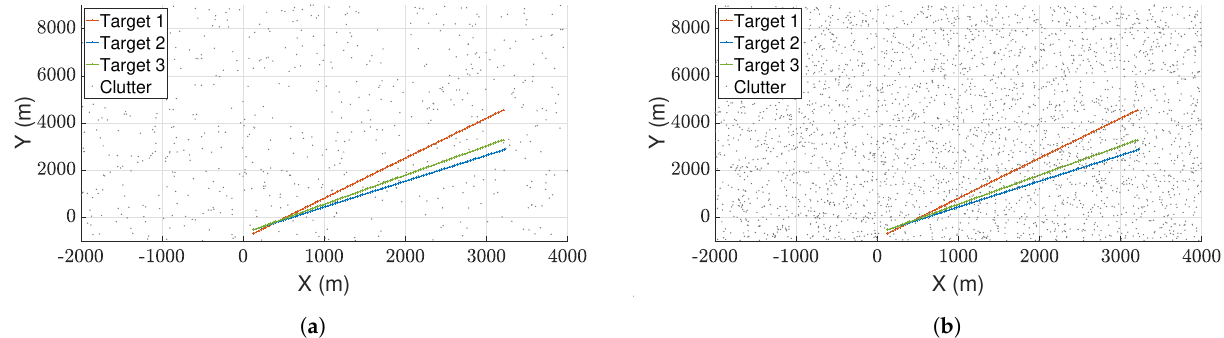
Figure 3. True target positions for three crossing targets with different clutter densities. ( a ) Clutter density λ = 1 × 10 − 4 /m 2 ; and ( b ) clutter density λ = 5 × 10 − 4 /m 2 . Table 1. Average generalized optimal sub-pattern assignment (GOSPA) errors for tracking multiple crossing targets with clutter density λ = 3 × 10 − 4 /m 2